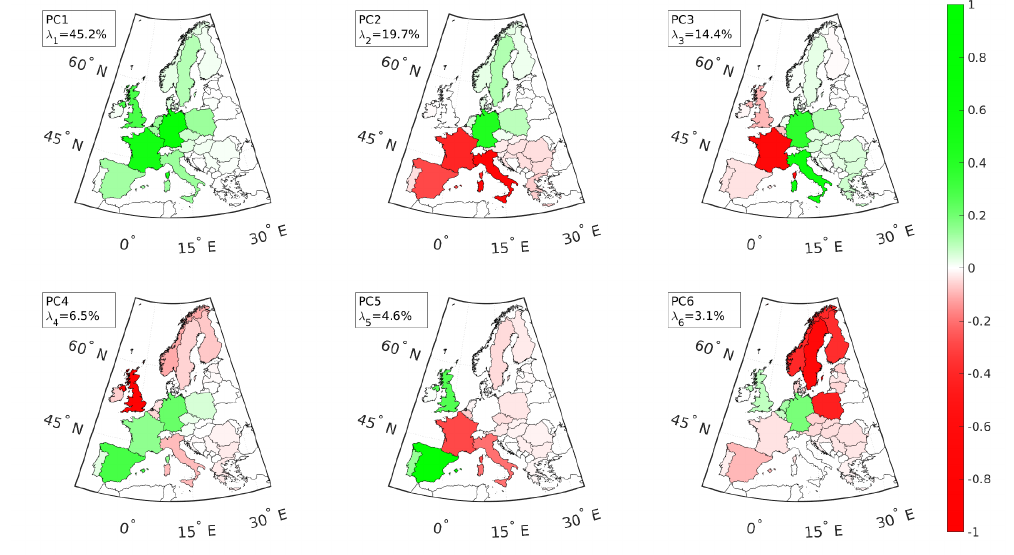
Figure 6. The six principal mismatch components for α = 0.8.